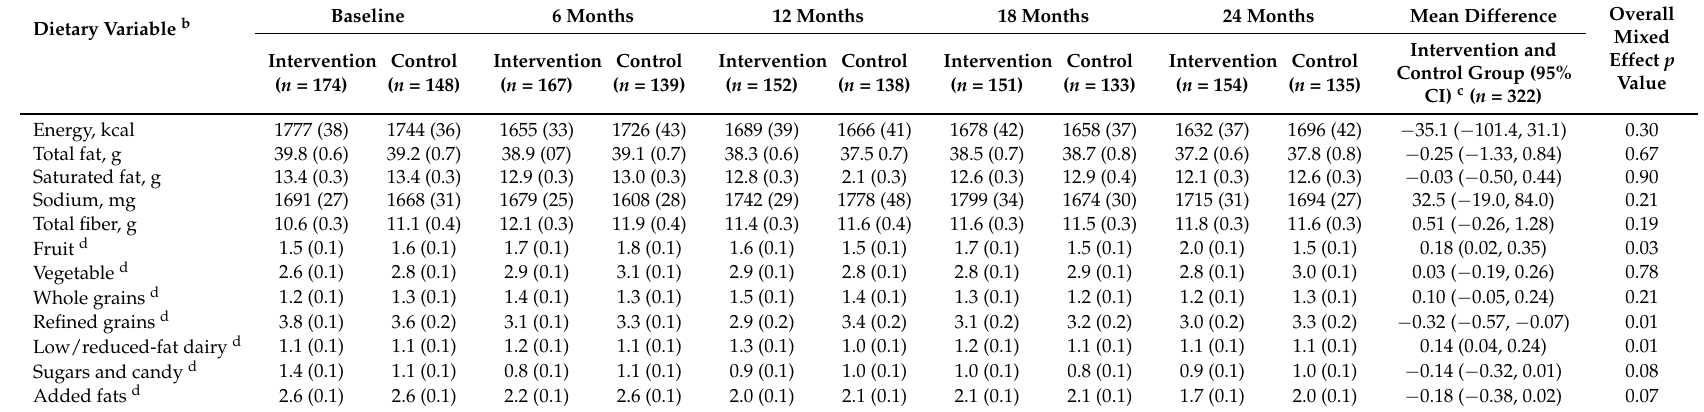
Table 3. Energy, nutrient, and food group intake (means and standard errors a ) among all midlife women participating in a weight gain prevention study for the intervention and control groups over 2-years.